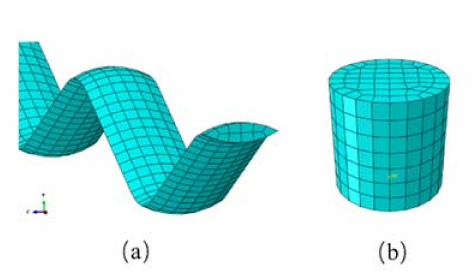
Figure 4. Mesh for the ( a ) yarn and ( b )